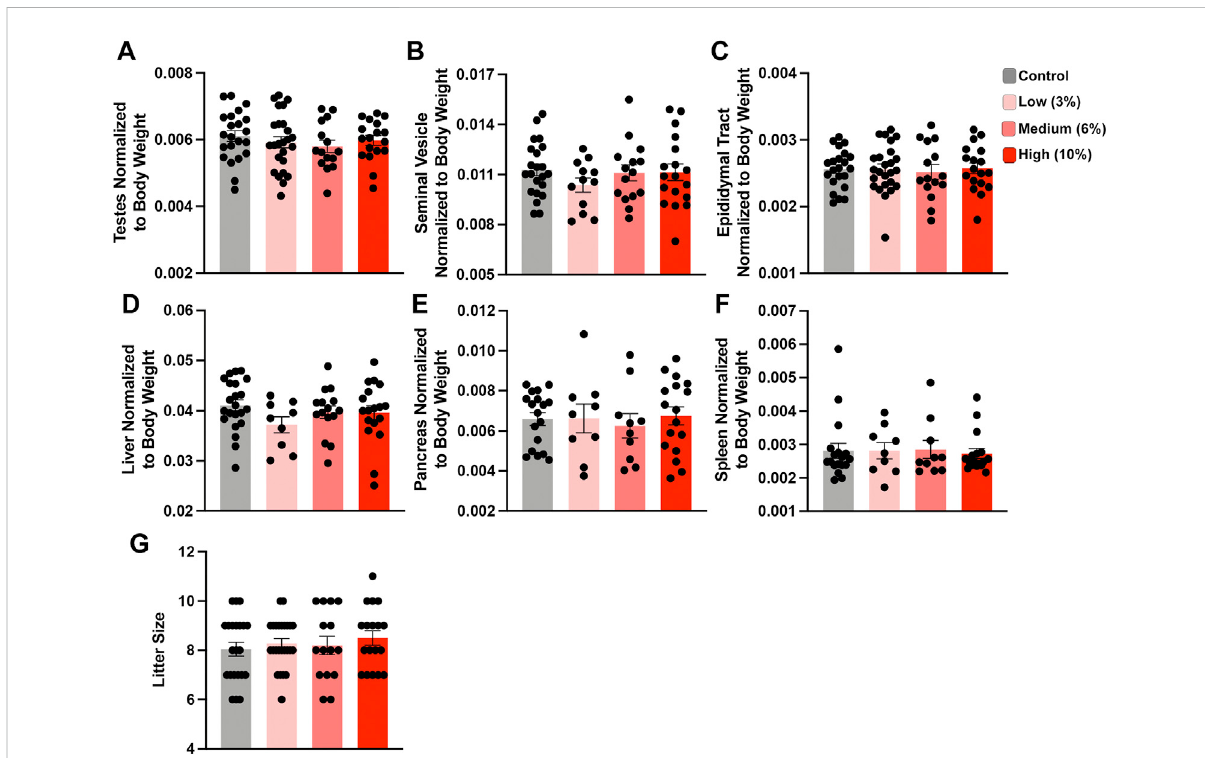
FIGURE 2 Chronic paternal ethanol exposures do not impact macro measures of male reproductive health or fertility. Paternal preconception alcohol exposuresdonotimpactlarge-scalemeasuresofmalereproductivephysiology,includingnormalized (A) testis, (B) seminalvesicle,or (C) epididymal track weights ( n =22 Control, 12-25Low,15 Medium, 18High).Chronicmale ethanolexposure does not impactnormalized (D) liver, (E) pancreas or (F) spleen weights ( n = 22 Control, 9 Low, 10-15 Medium, 17 High). (G) Chronic preconception paternal alcohol exposures do not in fl uence offspring litter size ( n = 22 Control, 25 Low, 15 Medium, 18 High litters). To assay changes between treatment groups, we used a one-way ANOVA. Error bars represent the standard error of the